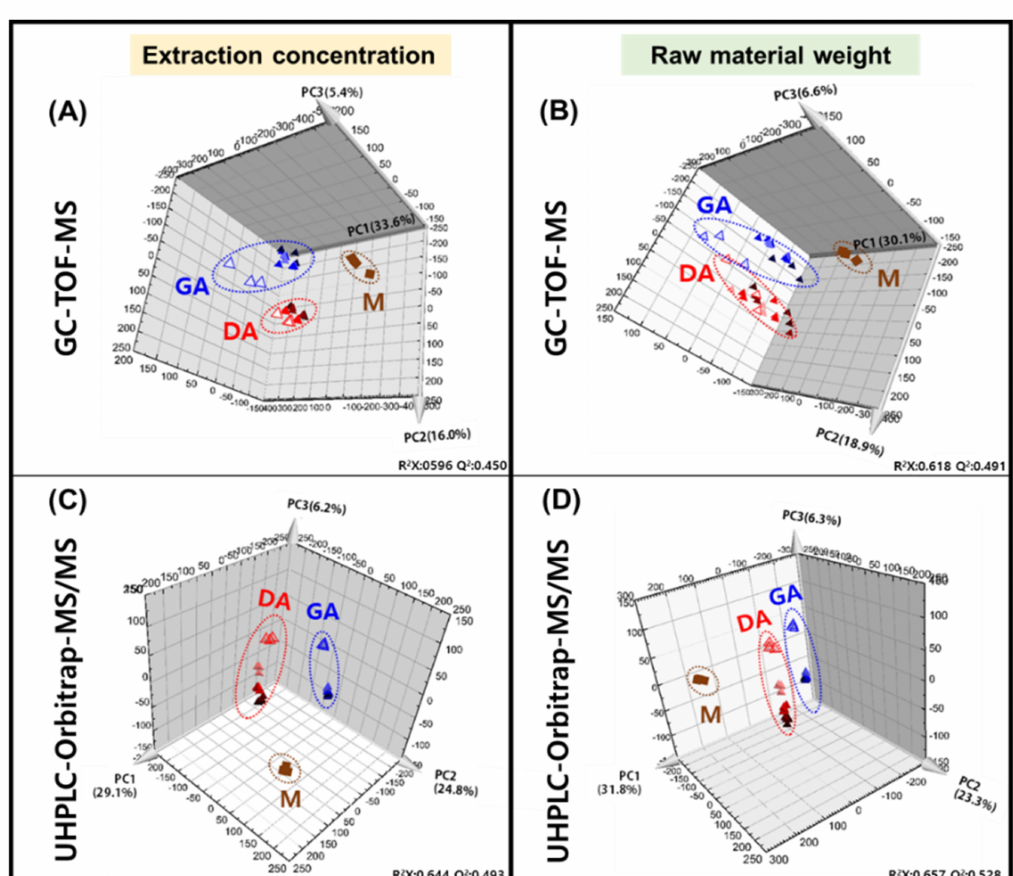
Figure 2. PCA score plots based on concentrations, as derived from Gas Chromatography Time-of-Flight Mass Spectrometry (GC-TOF-MS) ( A ) and Ultrahigh Performance Liquid Chromatography-Orbitrap-Mass Spectrometry/Mass Spectrometry (UHPLC-Orbitrap-MS/MS) ( C ). Principal component analysis (PCA) score plots normalized to the raw material weight, as derived from GC-TOF-MS ( B ) and UHPLC-Orbitrap-MS/MS ( D ). Different processes are symbolized as meju (raw material: (cid:7) ), doenjang aging (0 d: (cid:78) ; 60 d: (cid:78) ; 90 d: (cid:78) ; 120 d: (cid:78) ; 360 d: (cid:78) ), and ganjang aging (0 d: (cid:78) ; 60 d: (cid:78) ; 90 d: (cid:78) ; 120 d: (cid:78) ; 190 d: (cid:78)